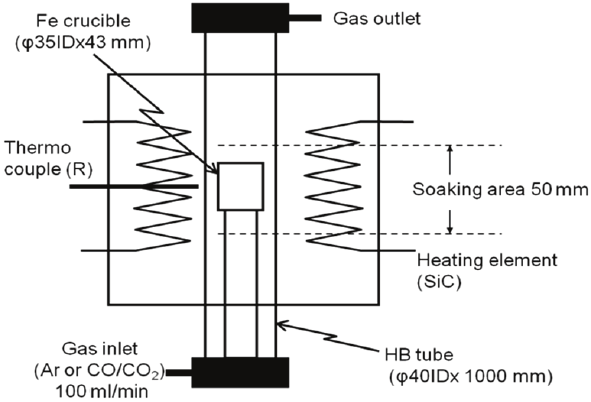
Figure 1. Experimental